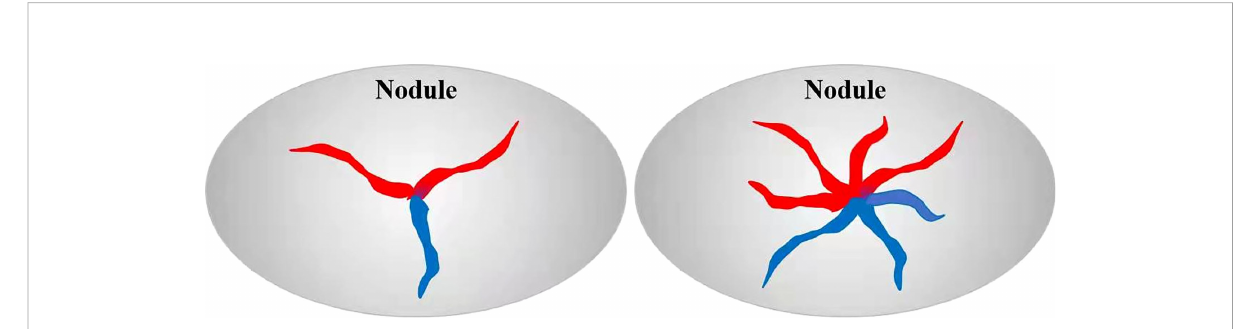
FIGURE 1 Schematic diagram of spoke wheel blood fl ow. Red: blood fl ow towards the probe, blue: blood fl ow away from the